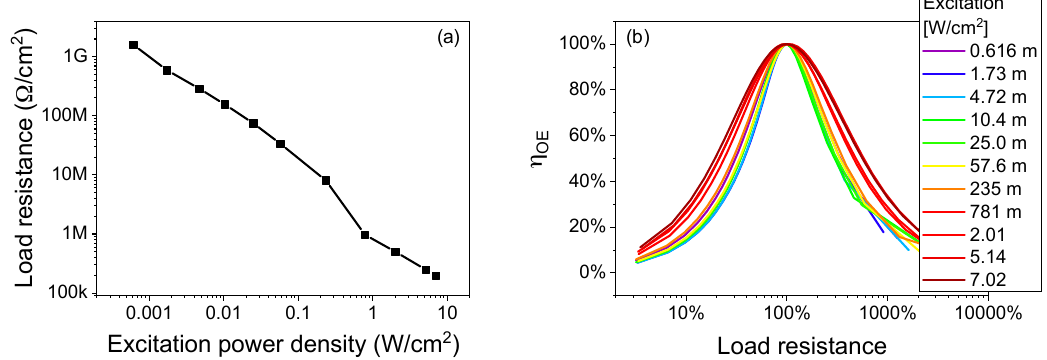
Figure 4. ( a ) Optimal load resistance value at different excitation power levels of the designed wireless power transfer system and ( b ) experimental variation in efficiency when the load resistance is varied with respect to the optimal one.